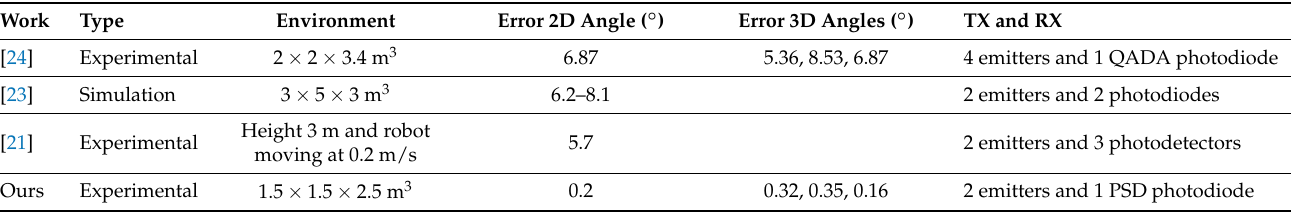
Table 3. Comparative with other state-of-the-art